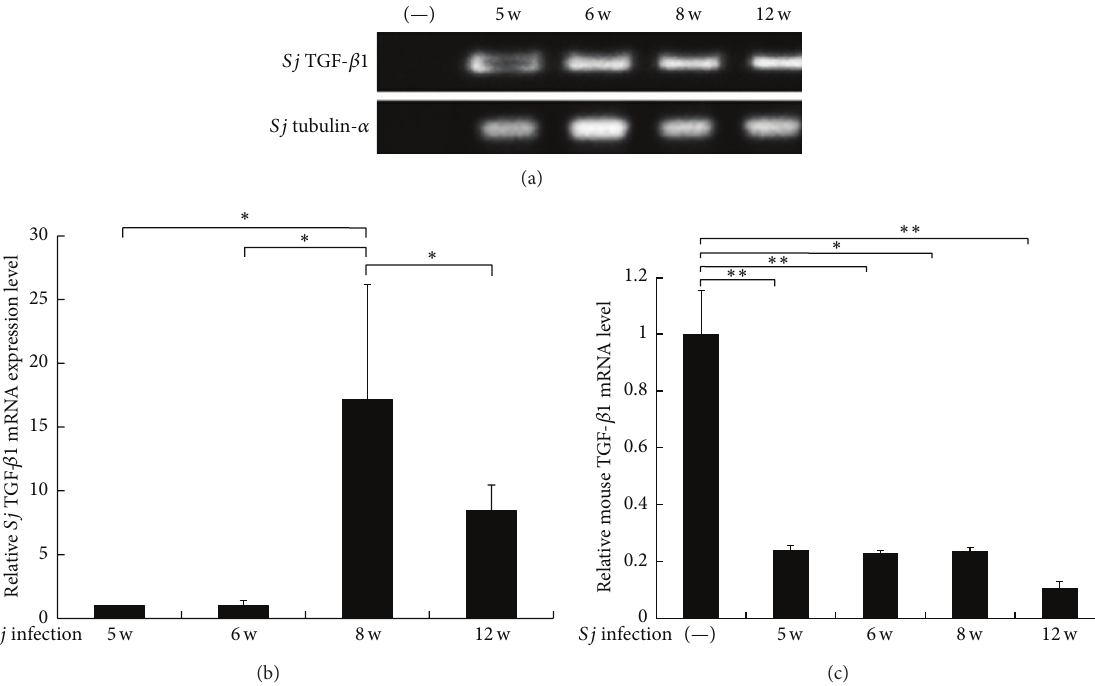
Figure 5: TGF- 𝛽 1 is transcribed in Sj and Sj -infected mouse liver. Equal amounts of total RNA from left lobes of BALB/c mice liver with 20±3 infective cercariae of Sj for 5, 6, 8, and 12 weeks were detected for TGF- 𝛽 1 mRNA expression in Sj by using PCR (a) and SYBR Green-based quantitative PCR (b). Sj tubulin- 𝛼 was detected as an input control. ∗ 𝑃 < 0.05 , ∗∗ 𝑃 < 0.01 . (c) Equal amounts of total RNA from infected mice livers at indicated time points were detected for mouse TGF- 𝛽 1 mRNA expression by SYBR Green-based quantitative PCR. GAPDH was detected as an input control. ∗ 𝑃 < 0.05 , ∗∗ 𝑃 < 0.01